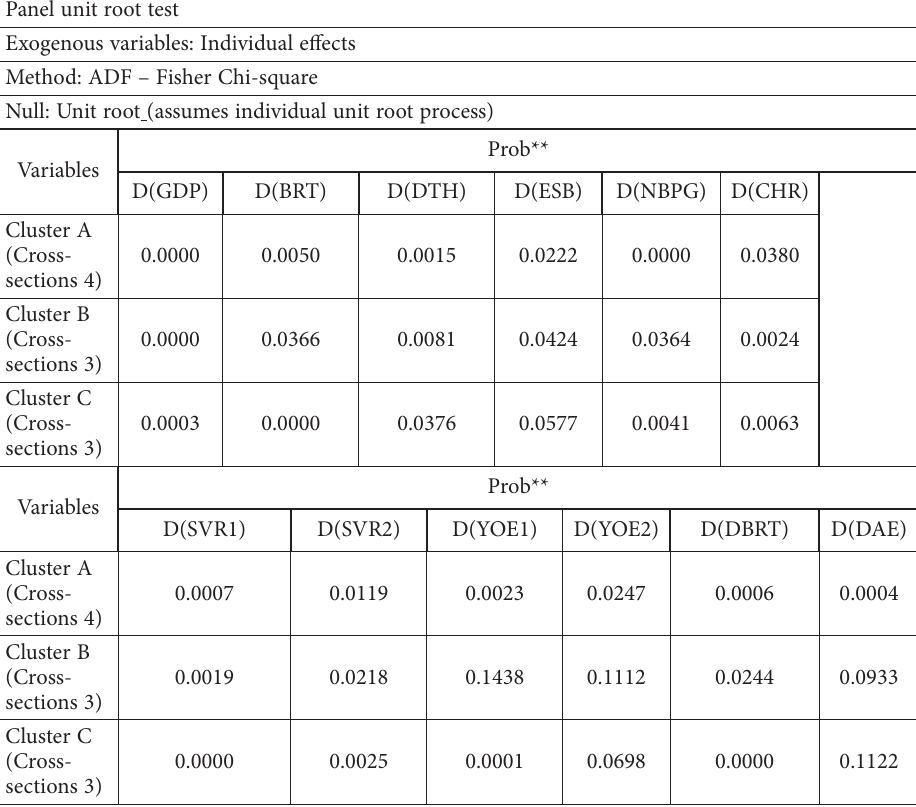
Table 4. The results of Unit Root Test (1 st difference) for data series included in the analysis (source: authors ‘own